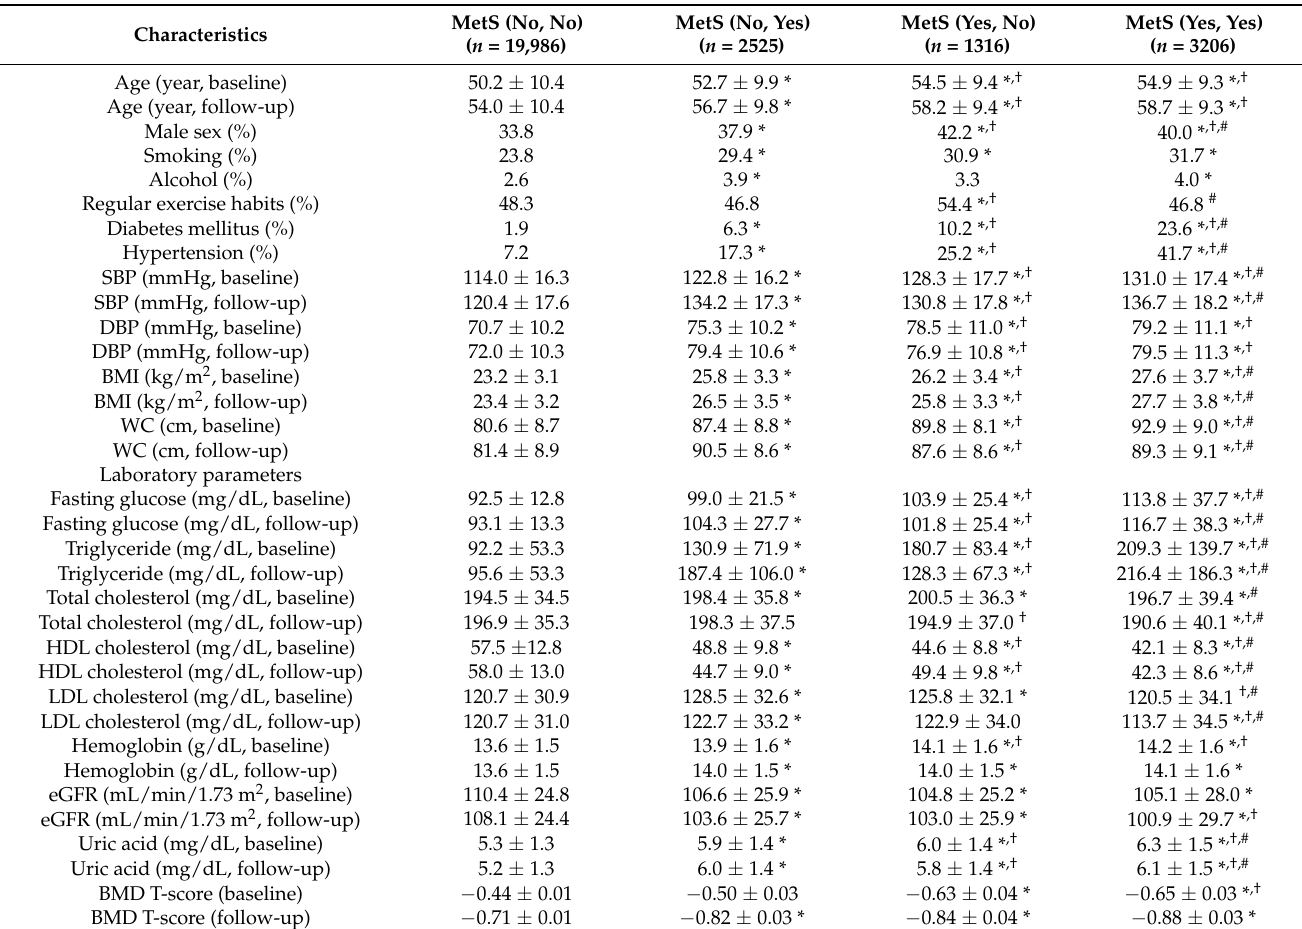
Table 1. Comparison of clinical characteristics among study groups according to MetS status (baseline, follow-up).